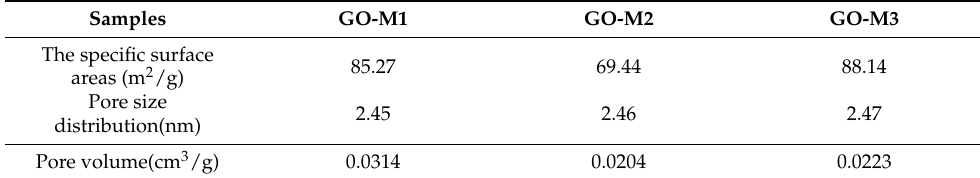
Figure 4. Nitrogen adsorption (black lines) and desorption (red lines) isotherms and pore size distributions of GOs: ( a ) GO-M1, ( b ) GO-M2 and ( c ) GO-M3; FTIR patterns of GOs ( d ). Table 3. BET of graphite powder and three types of